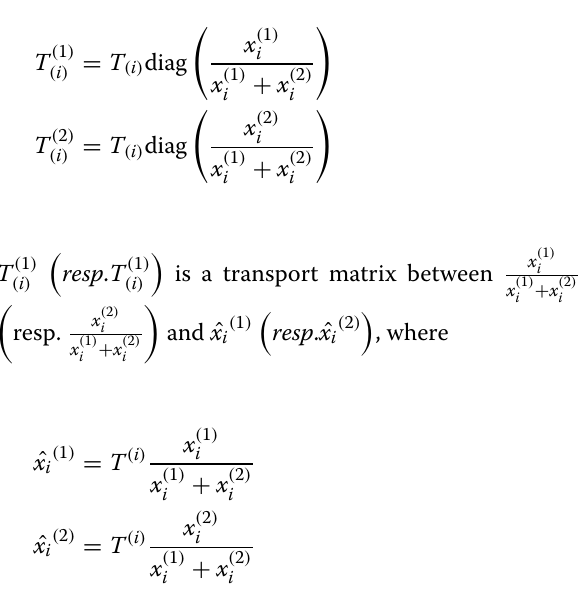
ˆ X ( 1 ) = X (cid:12) ( 2